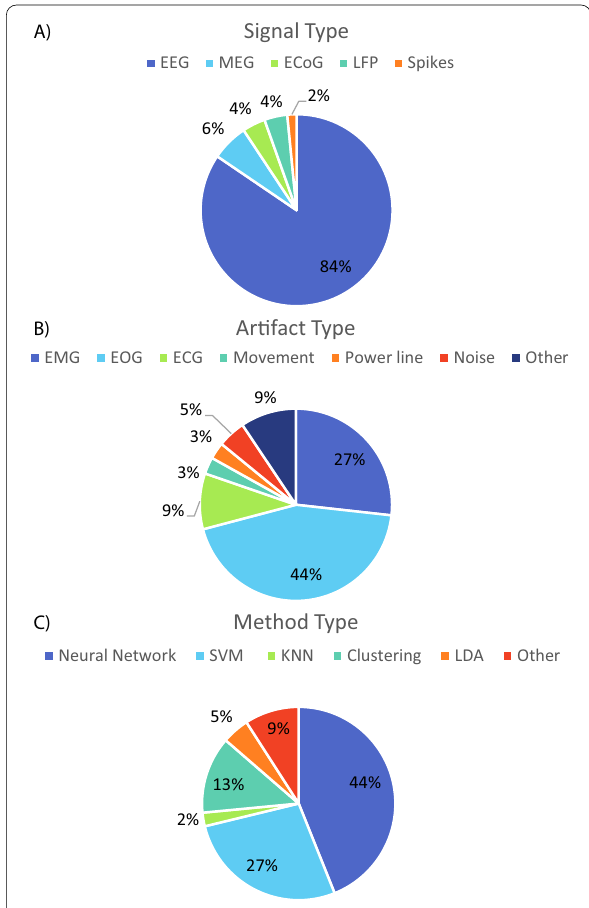
Fig. 7 Distribution of the A signal type and B artefact type, and